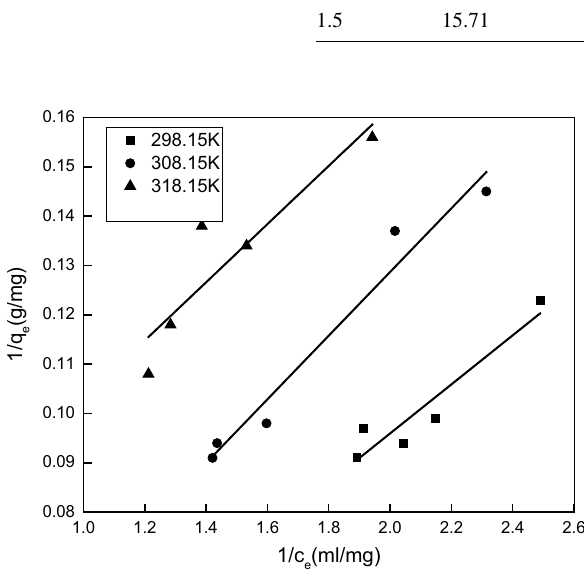
Fig. 12 Langmuir adsorption isotherm equation fitting diagram